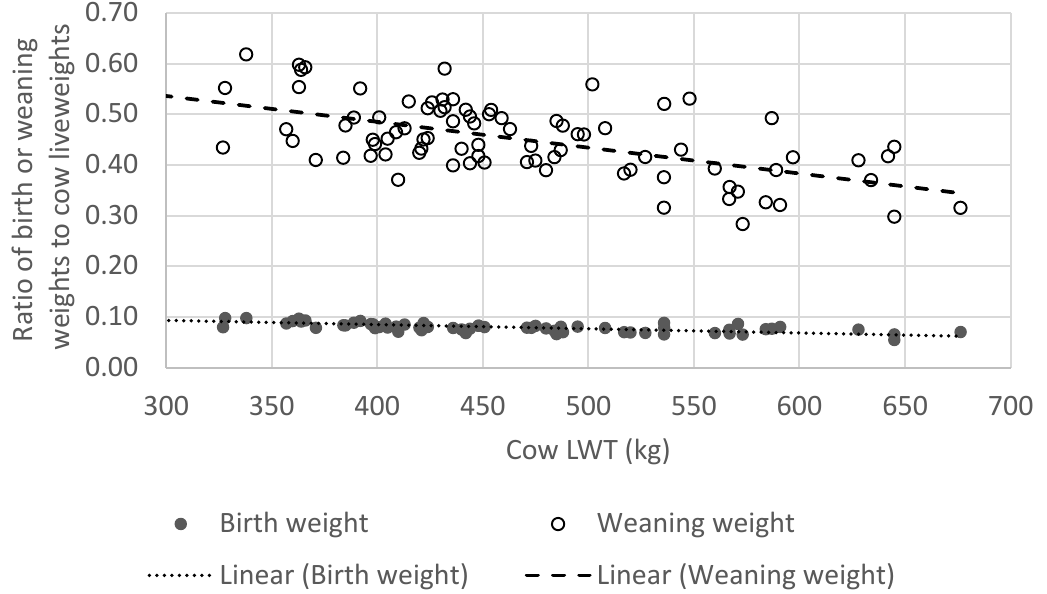
Figure 1. Ratio of calf birth and weaning weight to cow liveweight (LWT) [4,5,10,11,13–17,19–25]. Linear regressions were: weaning weight = 0.683 − 0.000466 × cow LWT and birth weight = 0.124 − 0.000097 × cow LWT.